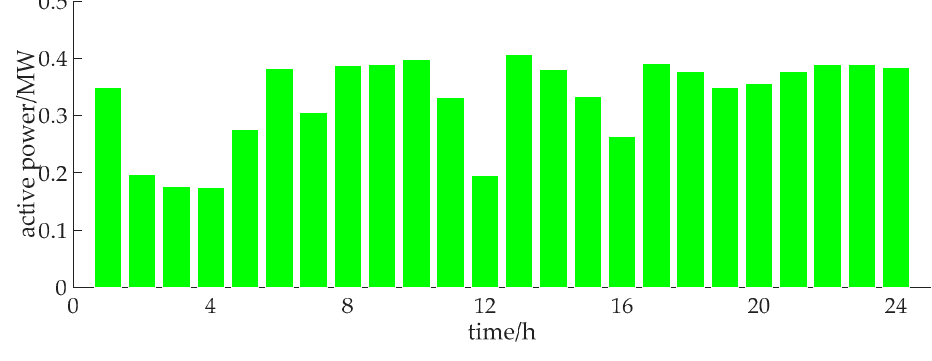
Figure 7. Wind power primary reserve.